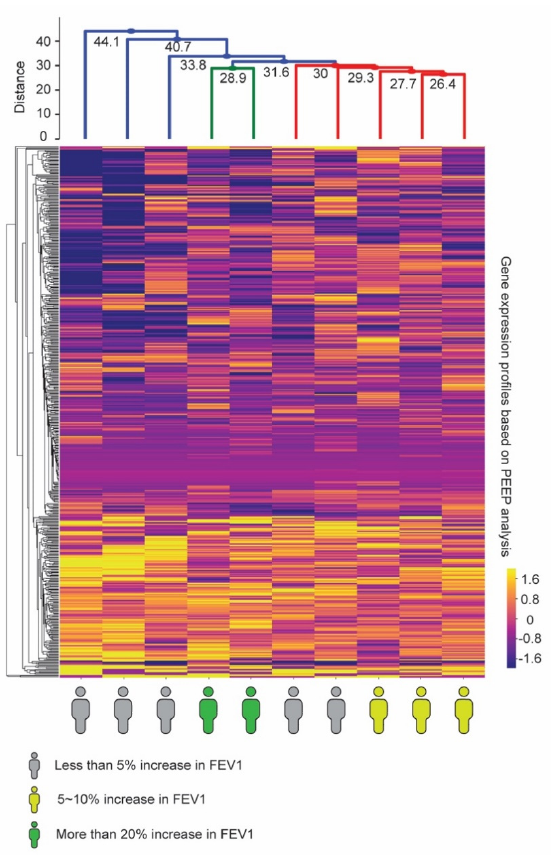
Figure 3. Individual patient gene expression profiles are associated with forced expiratory volume in 1 s (FEV 1 ) improvement on imatinib and are further distinguished by the degree of FEV 1 change. Patients in yellow demonstrated a weak (5–10%) increase in FEV 1 , while patients in green demonstrated a strong (>20%) improvement in FEV 1 . Profiles of weak responders shared no common genes with z-scores above 2 or below − 2 and there were no common up- or down-regulated pathways. Similarly, imatinib- treated patients without improvement in FEV 1 shared no common up- or down-regulated biological processes, suggesting that the lack of drug response in these patients may stem from heterogenous factors. In contrast, we found four genes were commonly repressed across the strong responders compared to the imatinib-treated population in the PEEP analysis: MPV17L2 ( p = 0.02), CNIH2 ( p = 0.02), AP1M2 ( p = 0.04), PTPMT1 ( p = 0.04). We found that these strong responders uniquely shared multiple downregulated mitochondrial-related pathways, such as mitochon- drial ribosome assembly, gene expression, and localization (Supplementary Table S2). Among weak responders, and non-responders, none of these pathways were significantly affected.